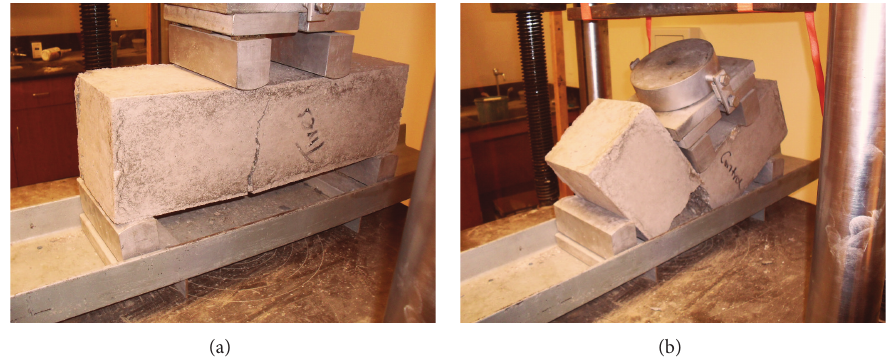
Figure 9: (a) Failure pattern for 7.5% TDA-1 󸀠󸀠 concrete beam. The beam did not fail into 2 halves and fracture line was not parallel to loading direction. (b) Failure pattern for Control-0% TDA concrete beam. The beam failed into 2 halves and fracture line was parallel to loading direction.